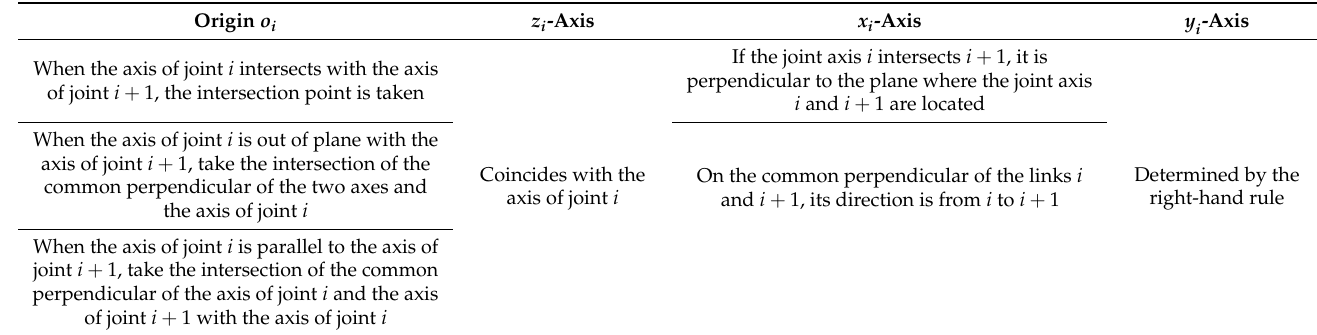
Table 1. Method for establishing a D-H coordinate